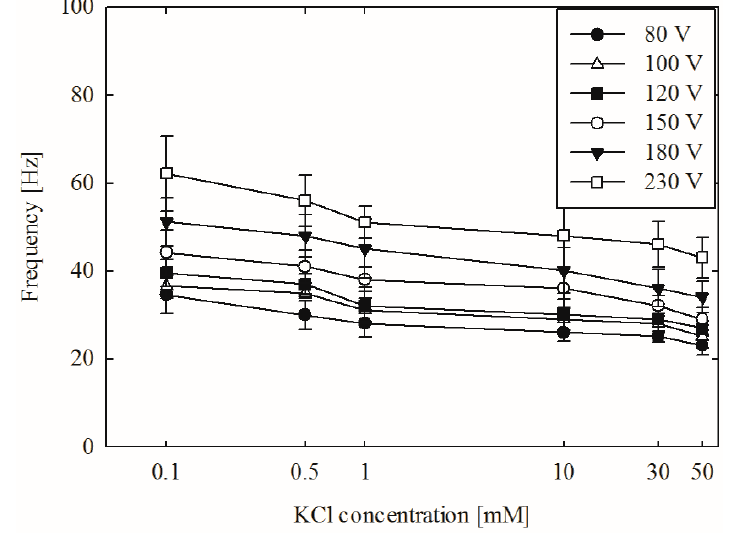
Figure 4. Spectral analysis results with different applied voltages.